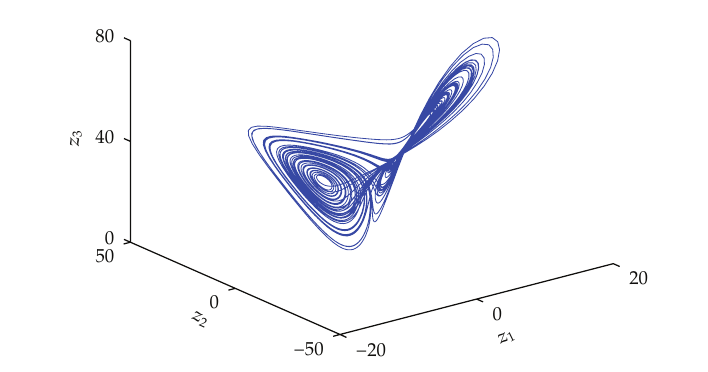
Figure 5: Chaotic attractors of the fractional-order Lorenz system (cid:2) 3.6 (cid:3) with (cid:2) σ,α,β (cid:3) (cid:7) (cid:2) 10 , 40 , 8 / 3 (cid:3) for q r (cid:7) 0 .